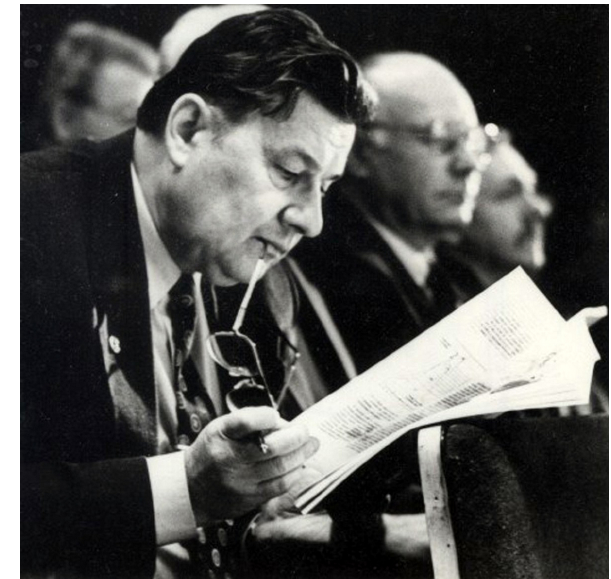
Figure 1. Geliy Alexandrovich Zherebtsov.